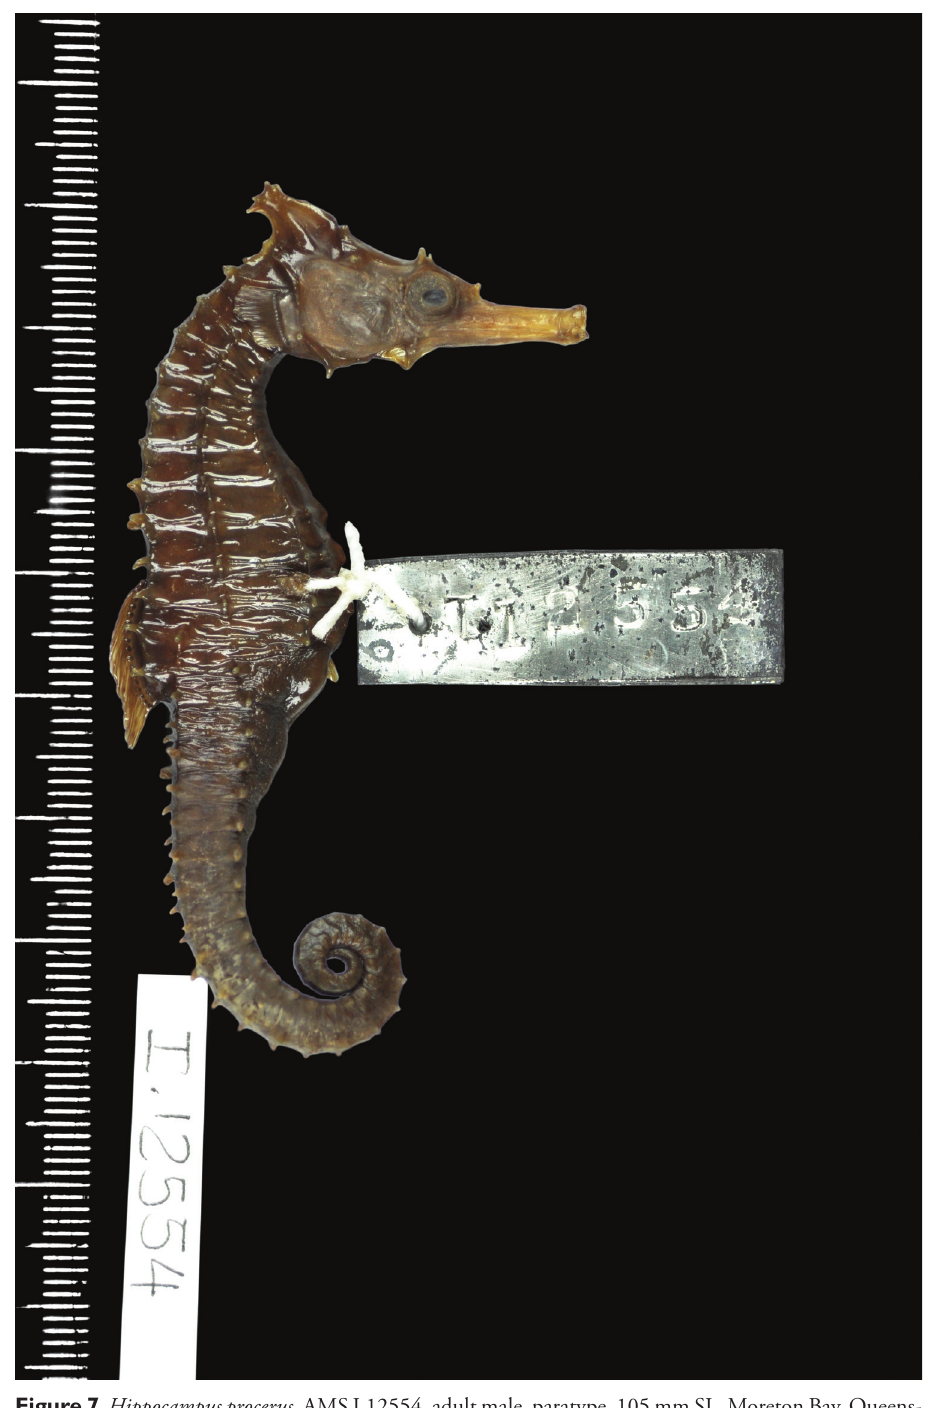
Figure 7. Hippocampus procerus , AMS I.12554, adult male, paratype, 105 mm SL, Moreton Bay, Queens- land, Australia (photograph Kerryn